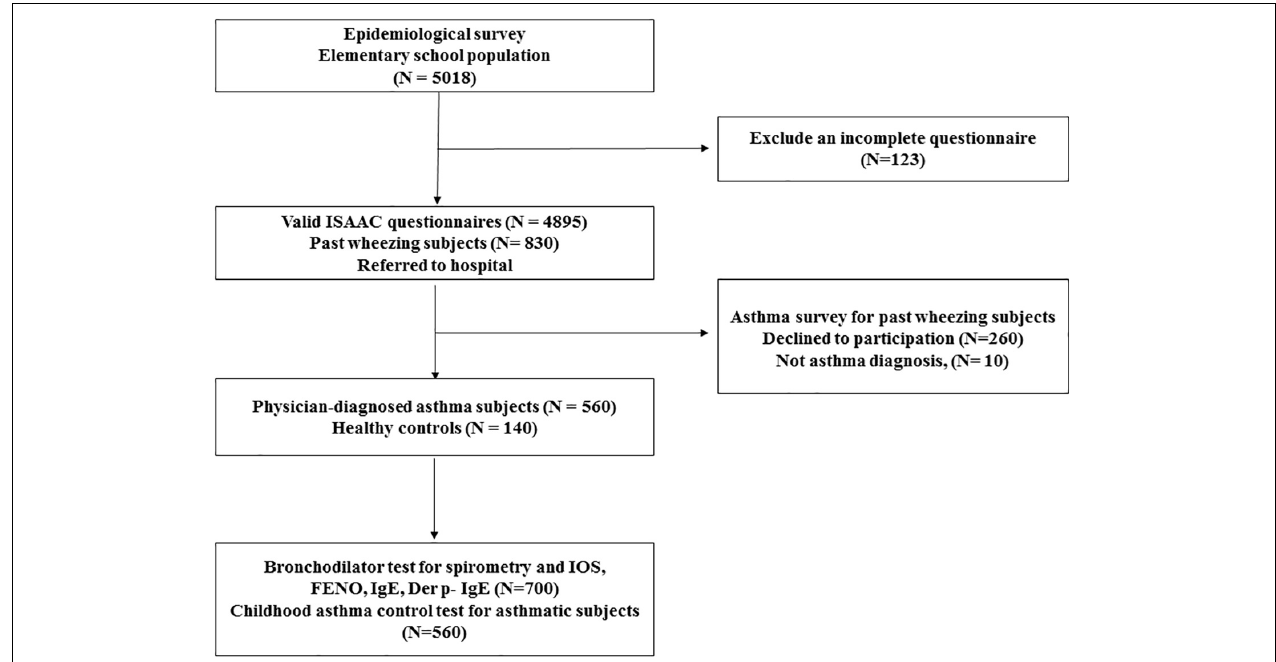
FIGURE 1 | The scheme of the study